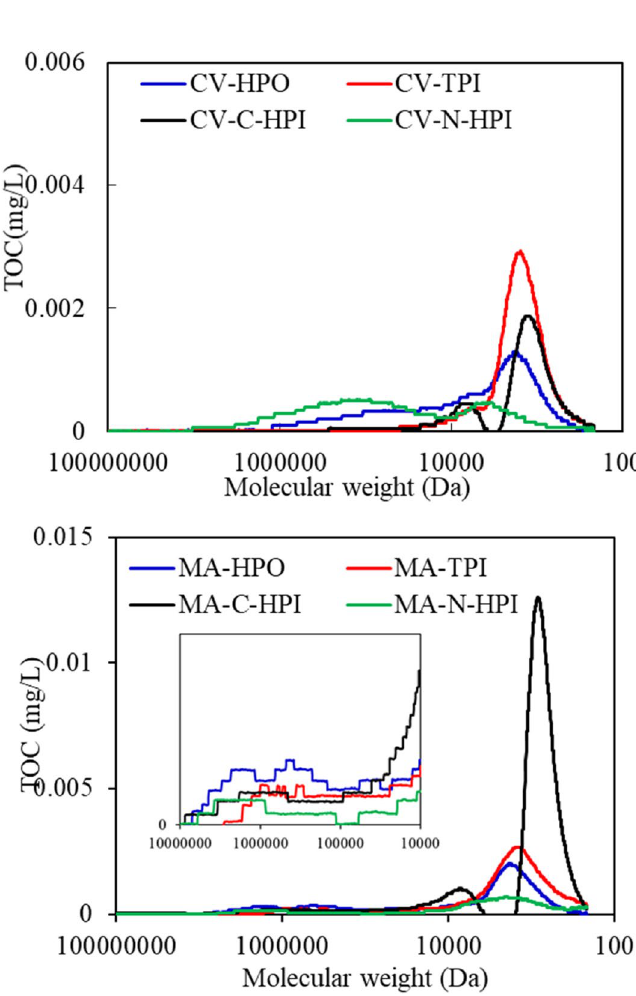
Figure 7. MW distributions of CV-IOM and MA-IOM fractions (DOC 5 ± 0.05